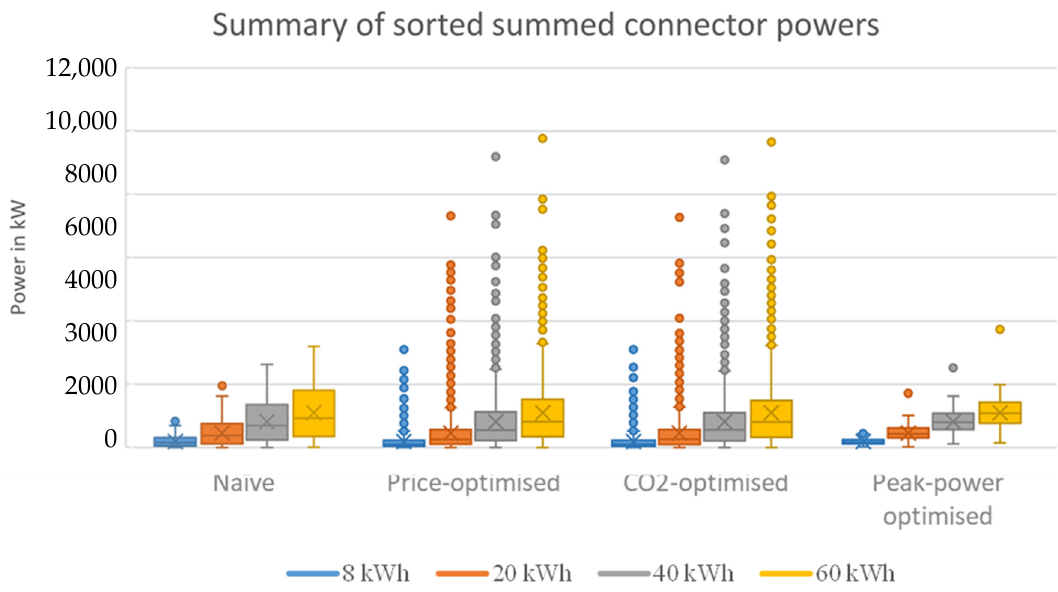
Figure 10. Summary box plot of the summed power values from Figures 11–14.